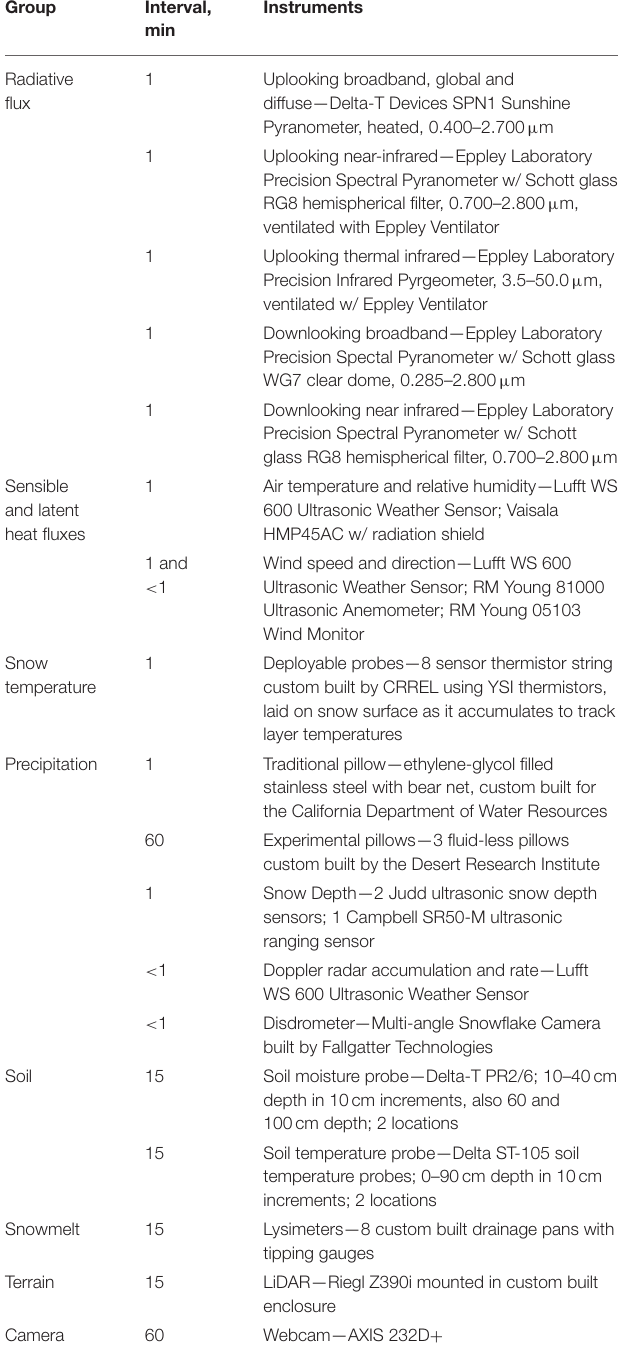
TABLE 2 | Summary of current instruments at CUES as of May